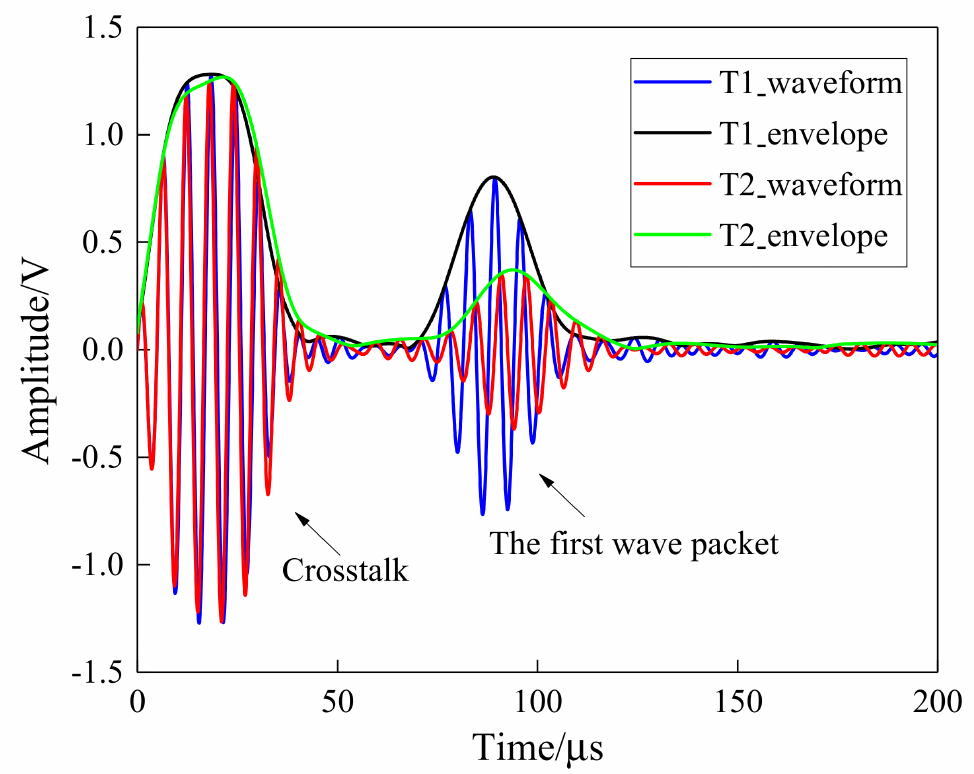
Figure 6. The Hilbert transform results on the received waveforms for one sensing path (T1 = initial moment, T2 = 20